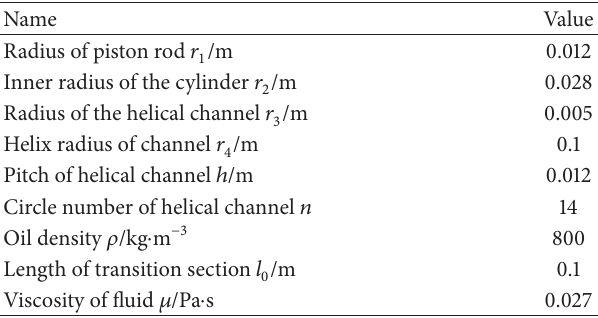
Table 1: Parameters of the fluid